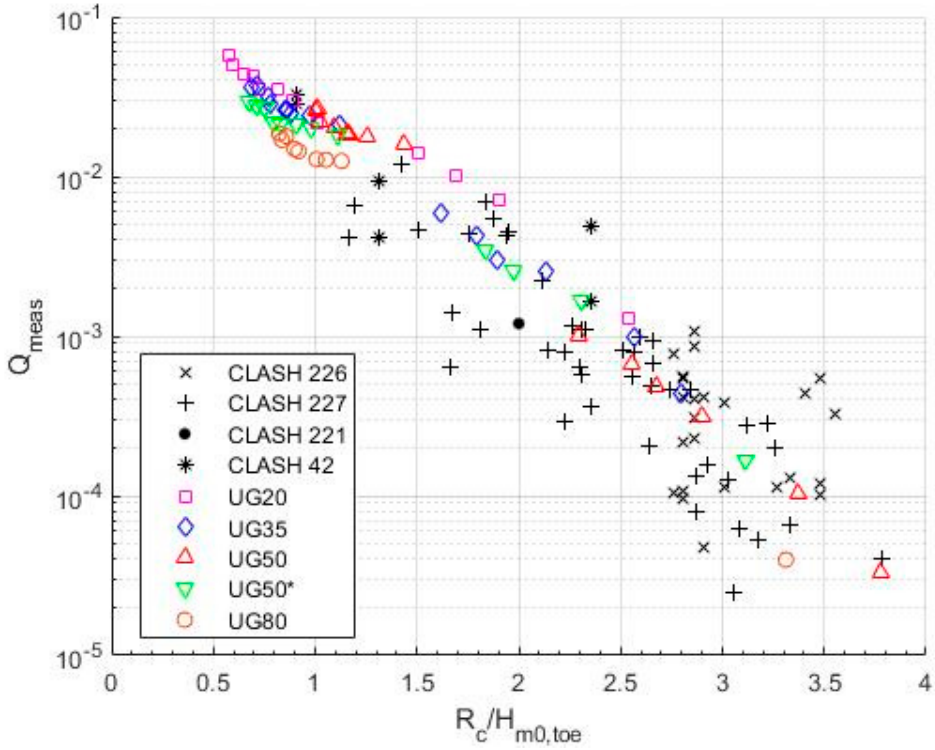
Figure 2. Variation in the dimensionless overtopping discharge versus relative freeboard.